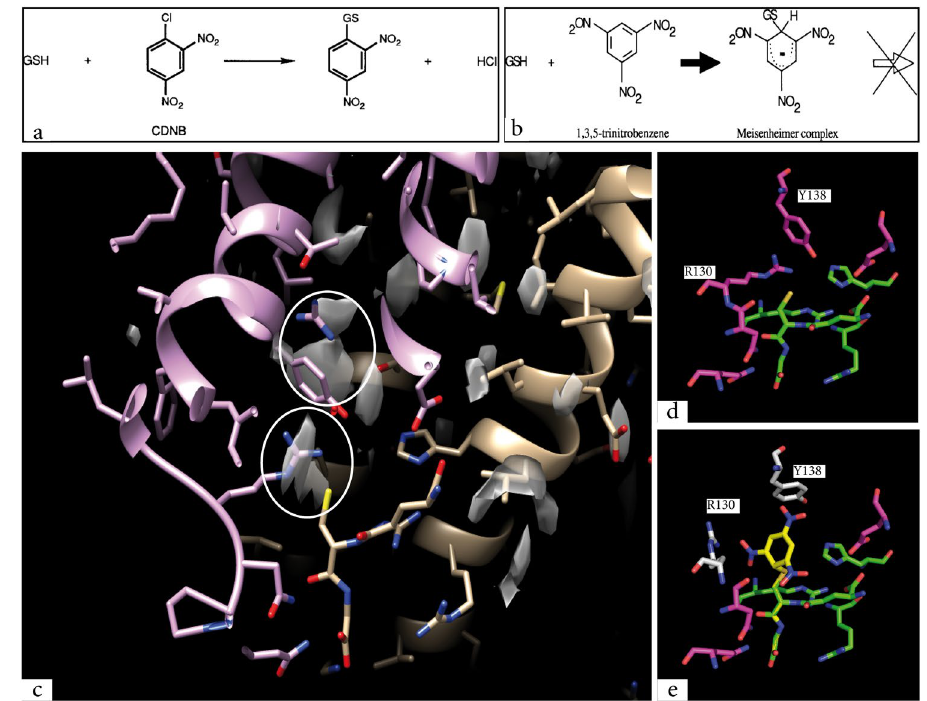
Figure 3. Formation of the reaction intermediate, the Meisenheimer complex. ( a ) Glutathione transferases act on lipophilic electrophiles bound to their hydrophobic binding site, positioning the substrate in close proximity to the activated thiol in GSH. ( b )1,3,5-Trinitrobenzene (TNB), which lacks a good leaving group, is known to reversibly form a Meisenheimer complex. ( c ) Difference map between TNB and native data shows peaks in the difference map ( σ = 2.6) close to the GSH molecule. ( d ) Side chain positions in the native model. ( e ) Tyr 138 side chain movement to match the upper difference-peak as shown in ( c ) and position of the TNB moiety to match the lower peak. Putative position of Arg130 to open the binding site for